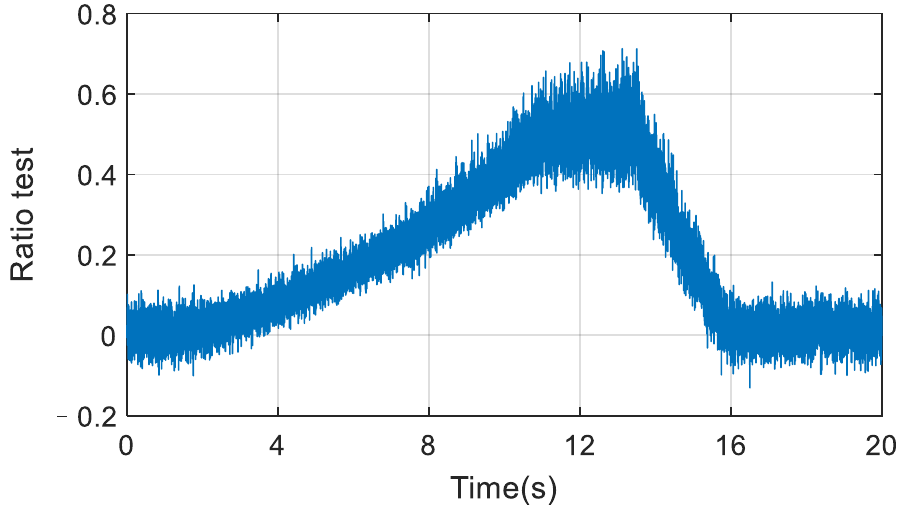
Figure 22. Ratio Test metric behavior under traction Strategy